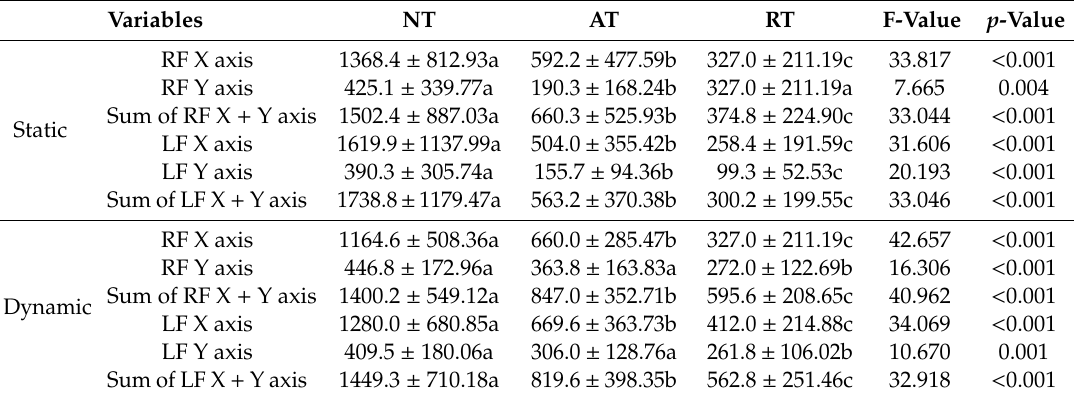
Table 3. Changes in static and dynamic balance performance (mean ±